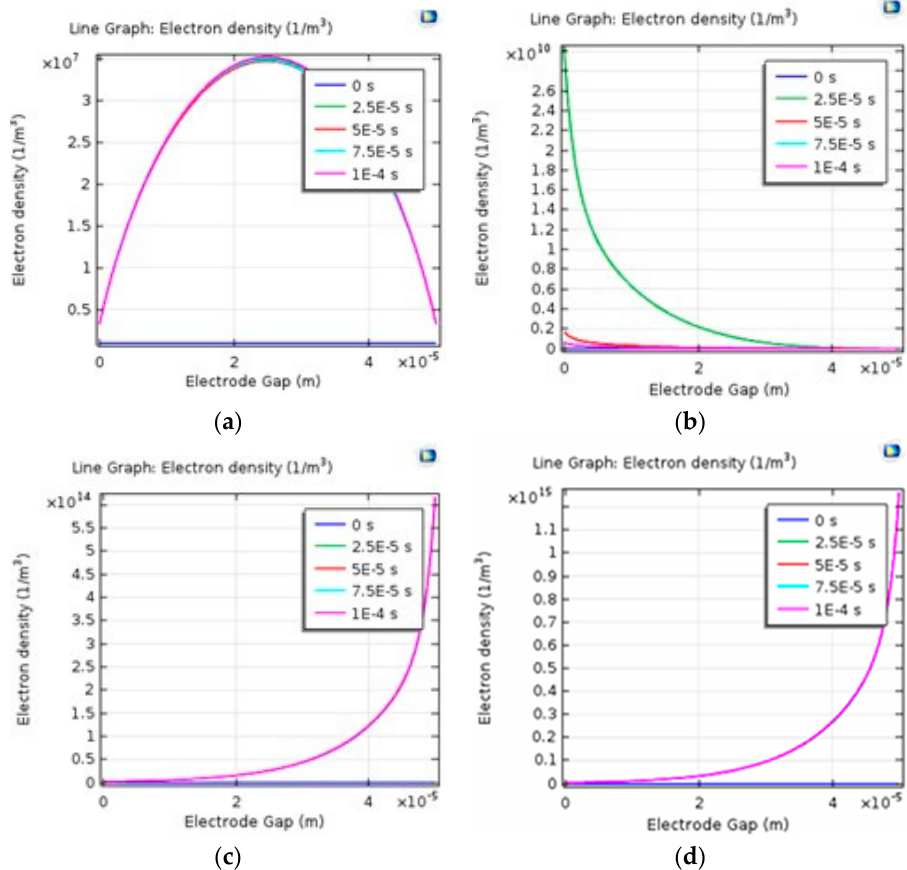
Figure 3. Electron density across the surface of the terminal and ground electrodes for increasing